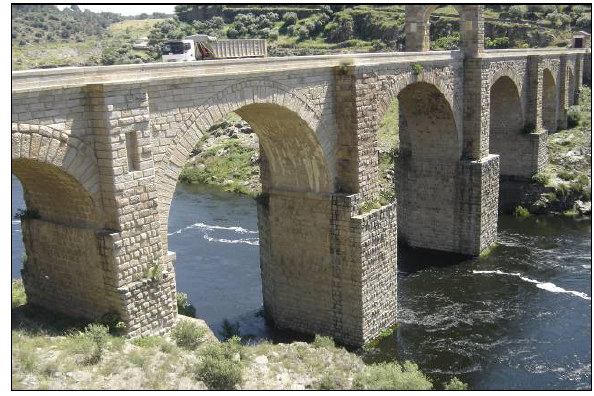
Figure 5. View of pile 4 under the triumphal arch.